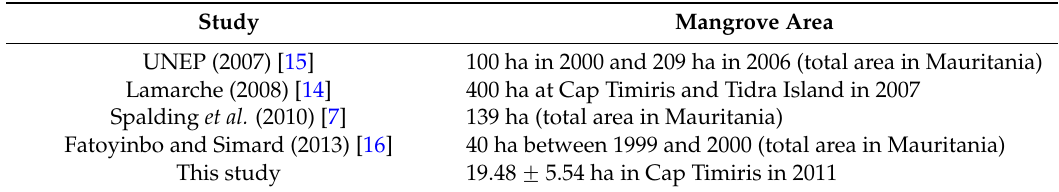
Table 3. Available mangrove area estimations in